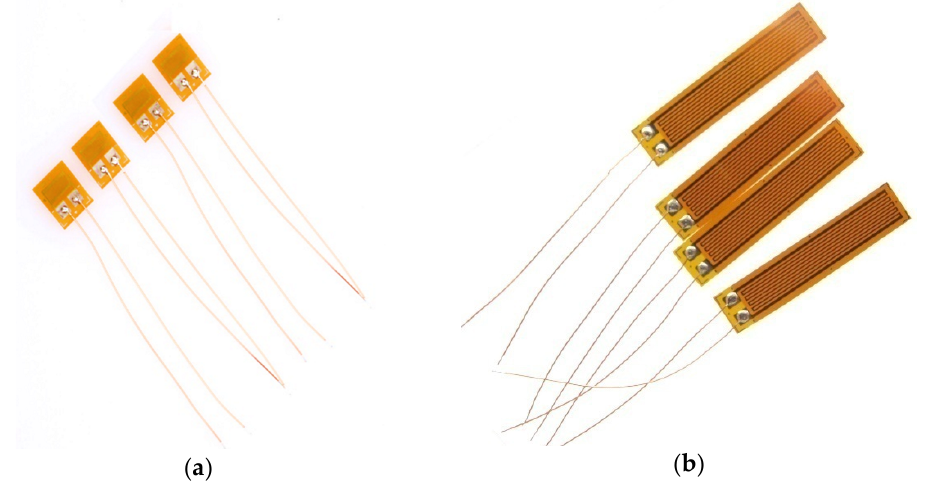
Figure 7. Types of strain gauges. ( a ) BF350-1AA. ( b ) BF120-20AA. Table 6. Strain gauge properties used in the present study.